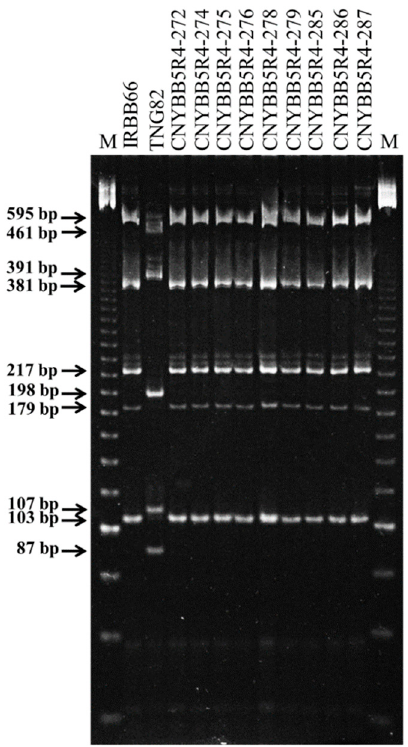
Figure 3. Multiplex PCR amplification of five bacterial blight resistance genes, Xa4, xa5, Xa7, xa13 and Xa21 . The five expected band sizes of 217, 106, 179, 381 and 595 bp, correlated with Xa4, xa5, Xa7, xa13 and Xa21 , respectively, were amplified in IRBB66 and nine five-gene-pyramided lines using multiplex PCR. P1:IRBB66, P2:TNG82. DNA products were separated by 6% polyacrylamide gel in 0.5 × TBE at 100 v for 60 min. M: DNA ladder marker.